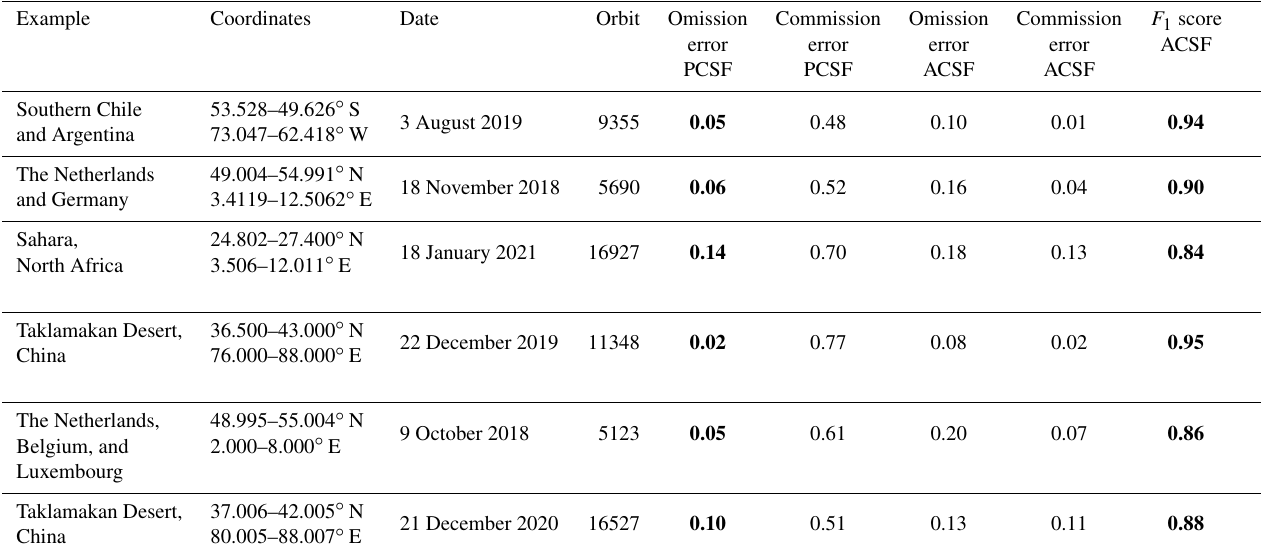
Table 1. Results of the validation of the PCSF and ACSF by inspection of VIIRS-NPP true-colour images. The final results are shown in